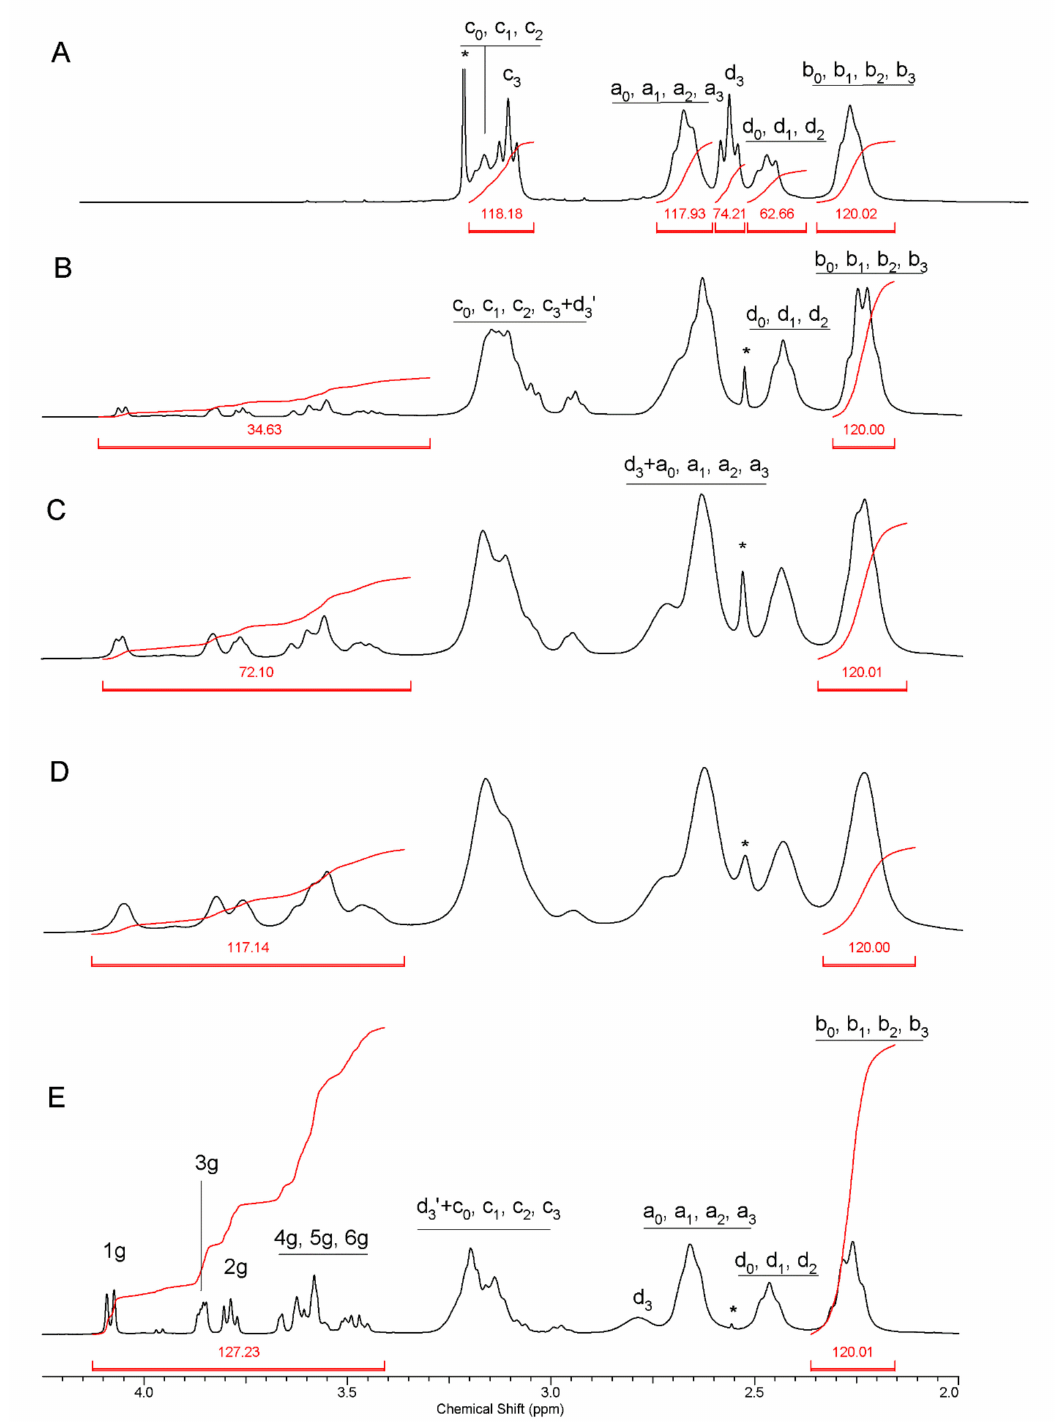
Figure 1. The 1 H-NMR spectra of starting PAMAM G3 dendrimer ( A ) and obtained glucoheptonamidated derivatives: ( B ) G3 5gh , ( C ) G3 10gh , ( D ) G3 16gh , and ( E ) G3 18gh in D 2 O. The PAMAM G3 resonances are labeled according to Scheme 1 (for detailed NMR studies on stepwise substitution on PAMAM G0 dendrimer, see Reference [10]). The residual solvent impurities (methanol in A and DMSO in traces B – E ) are labeled with